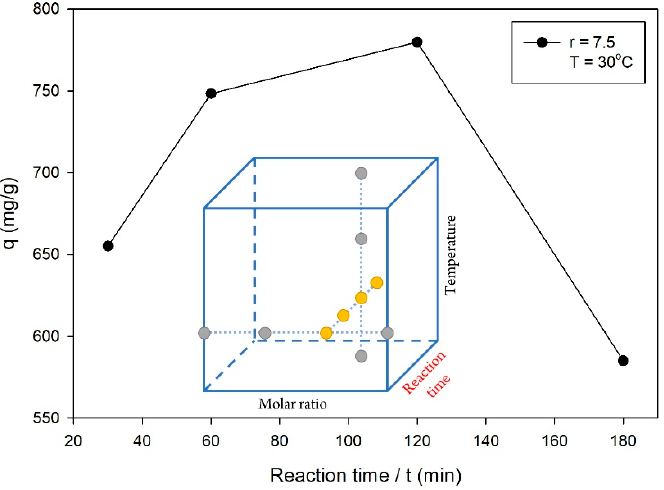
Figure 2. Effect of the reaction time on the 𝑞 value, with the following experimental conditions: molar ratio of ligand to metal = 7.5 and temperature = 30 ° C.